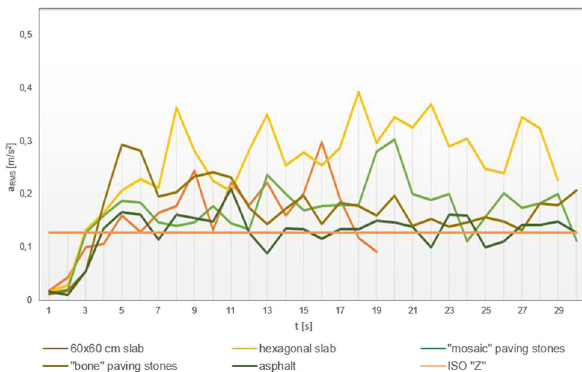
Figure 7: Variation in time of the amplitude vibration acceleration a RMS ( m/s 2 ) ( with the ISO comfort limit marked ) during the passage of a disabled person in an active wheelchair on di ff erent surfaces – fi ltration with a 1/3 octave fi lter 10 Hz, direction “ Z . ”